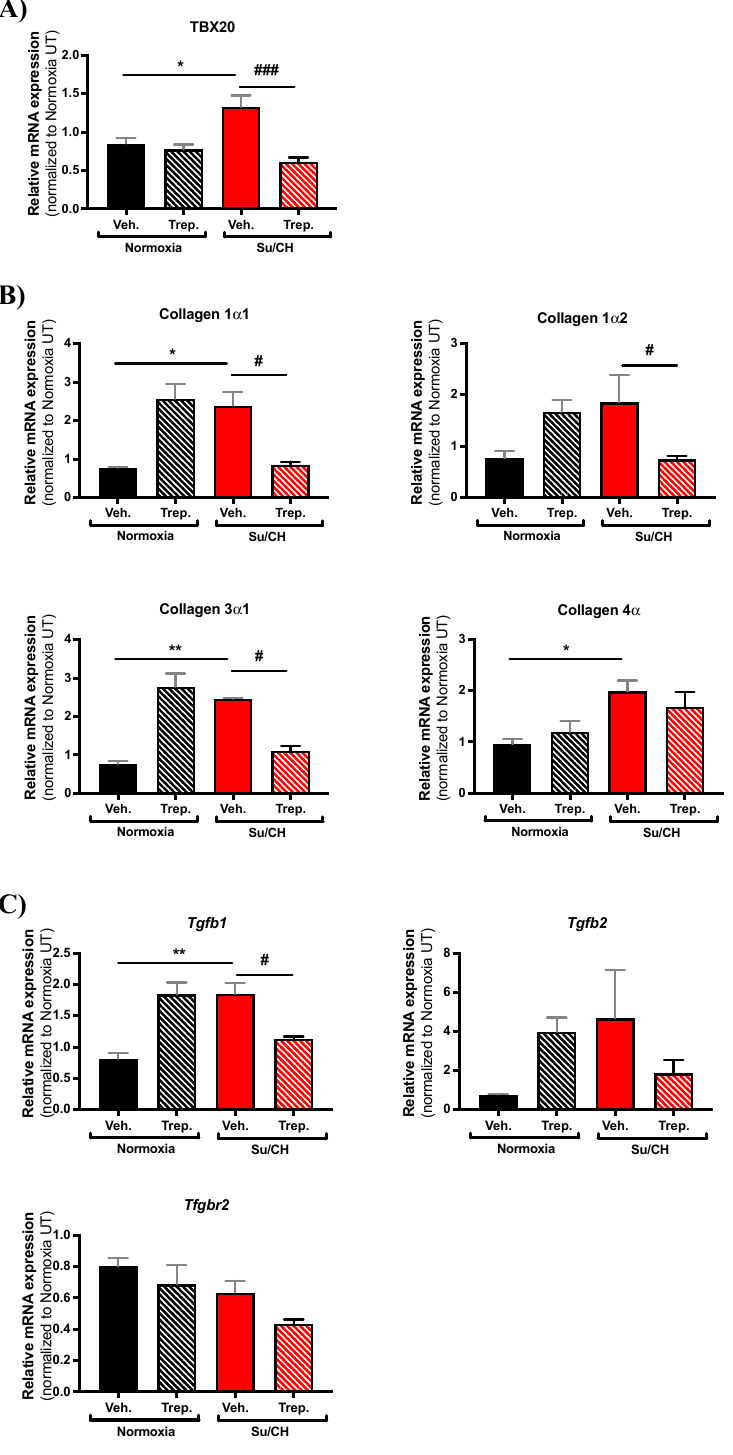
Figure 6. Expression change assessment of genes identified through custom RNA array. Bar graphs present quantified transcript levels of ( A ) Tbx20, ( B ) collagen subtypes as identified, and ( C ) TGF- β 1, TGF- β 2, and TGF- β 2 receptor (Tgfbr2) normalized to normoxia+Veh.; n = 3–5 animals/experimental group. * and # present significance vs. normoxia+Veh. and SuCH+Veh., respectively; * and # p ≤ 0.05; ** p ≤ 0.01; ### p ≤ 0.001.